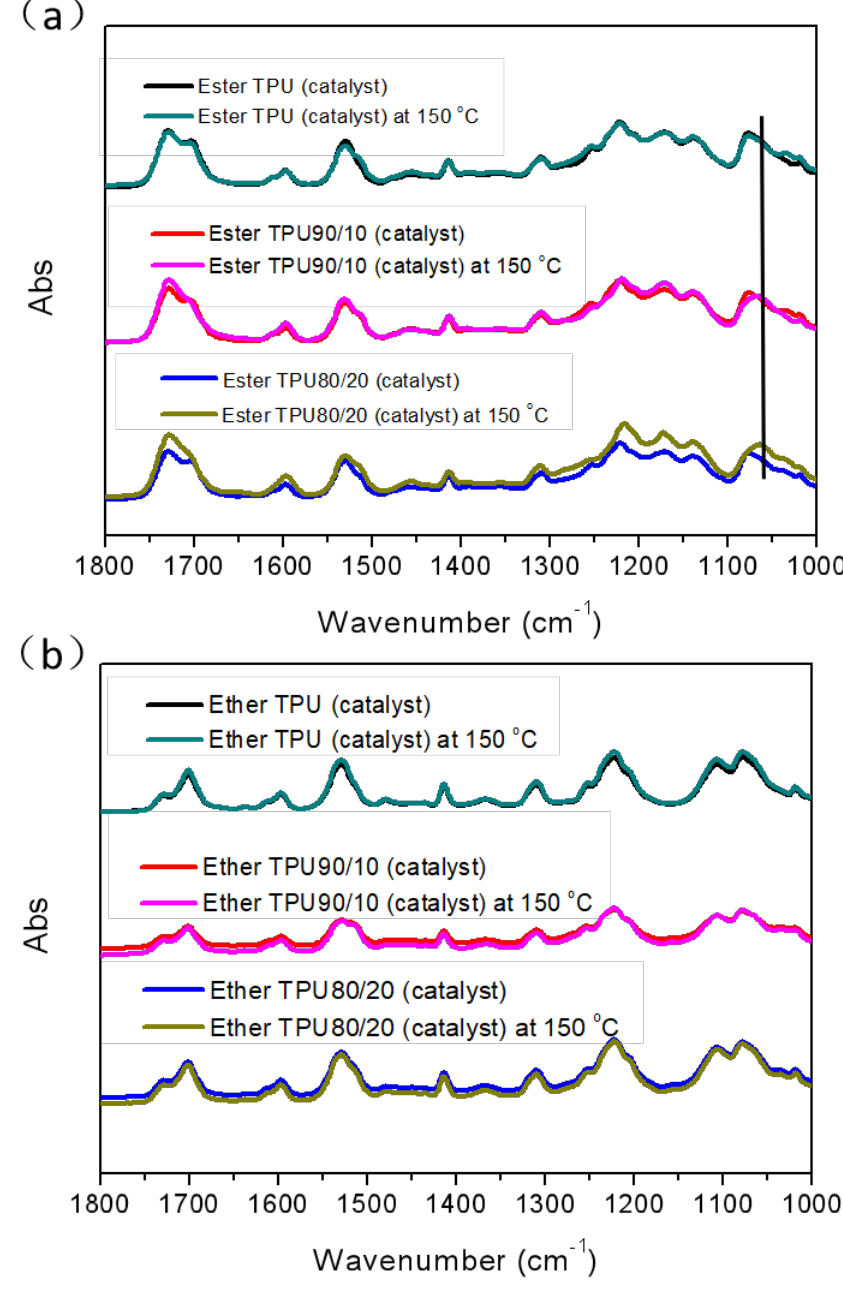
Figure 6. ATR-FTIR spectra of heat-treated TPU / phenoxy blends at low wavenumbers: ( a ) Ester TPU / phenoxy with the catalyst; ( b ) ether TPU / phenoxy with the catalyst.